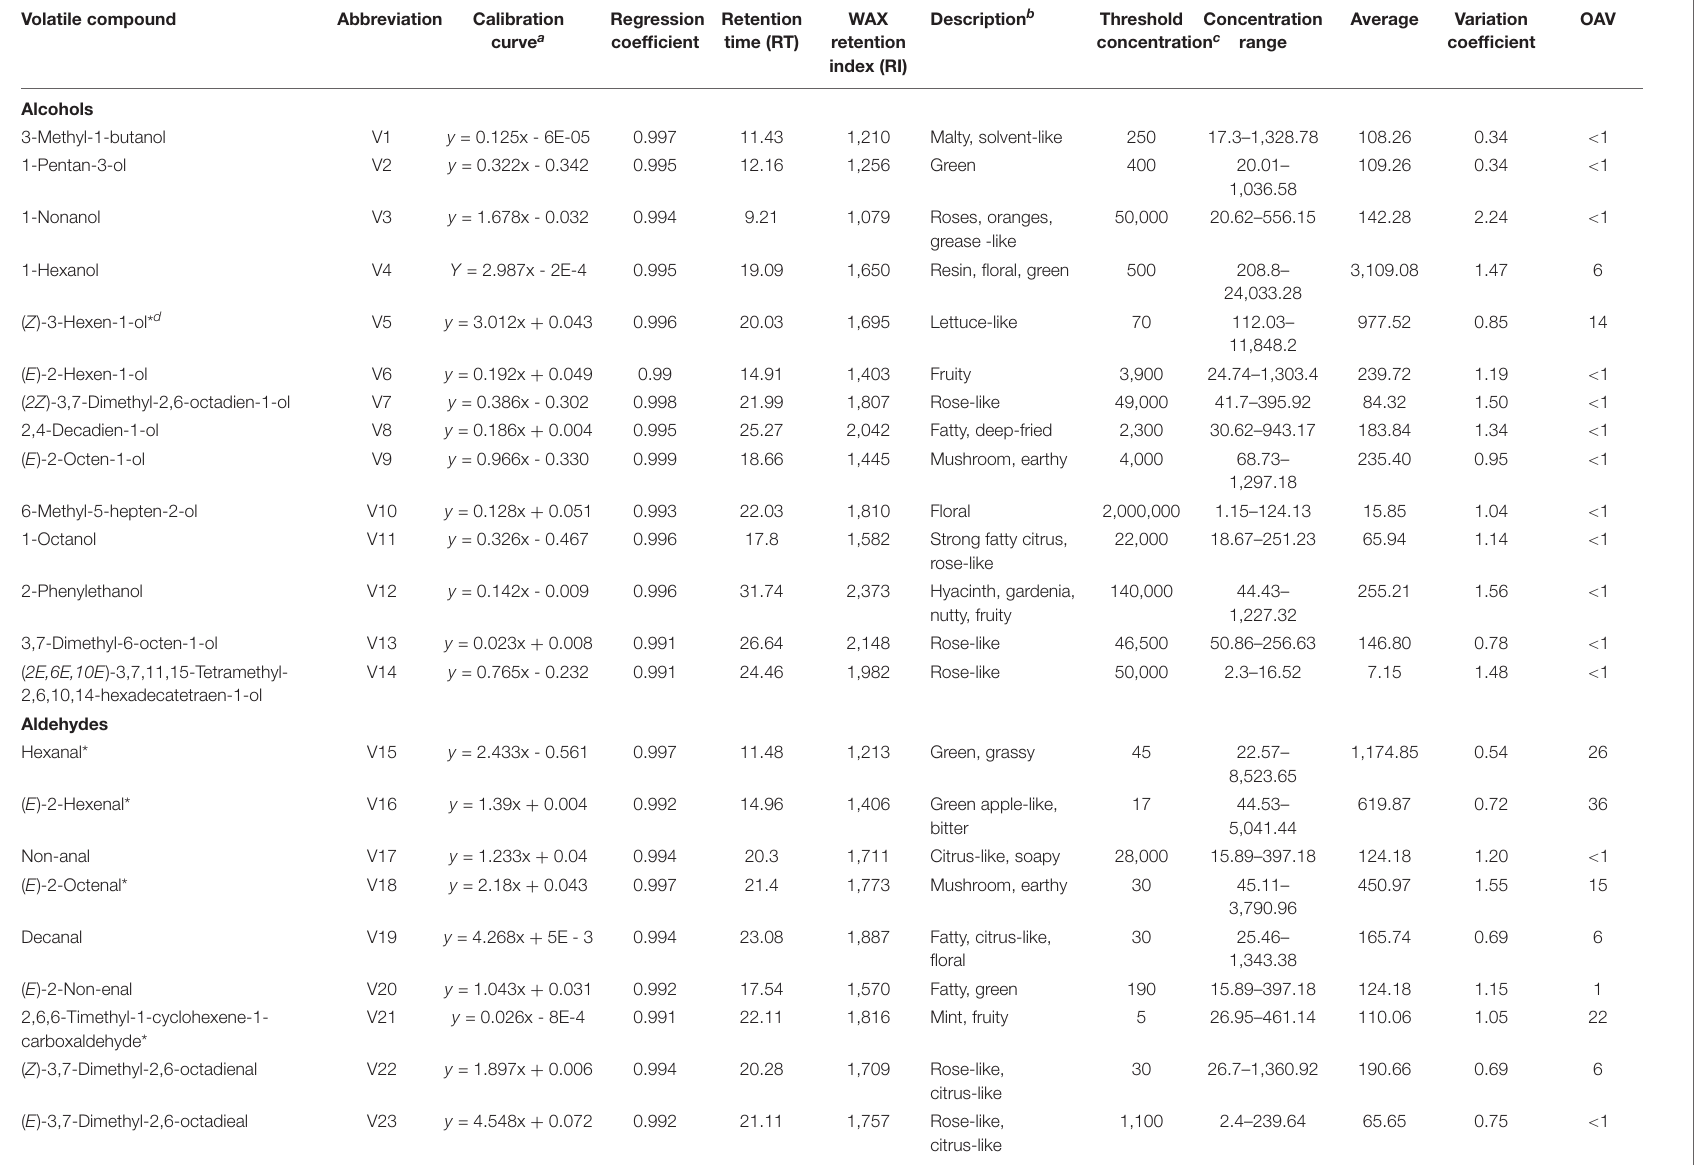
TABLE 2 | Concentrations of volatiles in mature tomato fruits (10 − 9 kg L − 1